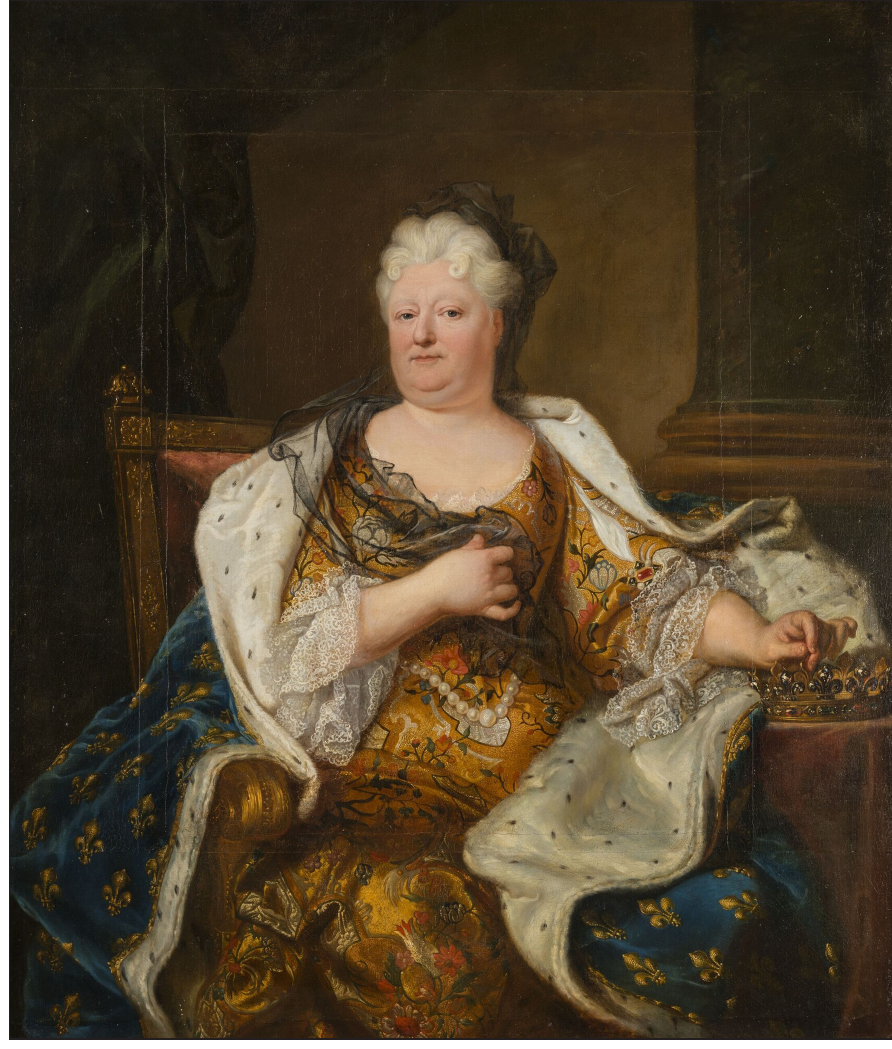
Fig. 2: After Hyacinthe Rigaud, Portrait of Elisabeth Charlotte of the Palatinate, Duchess of Orléans (1652–1722), c. 1713, oil on canvas, 132 × 109 cm, Palace of Versailles. Wikimedia